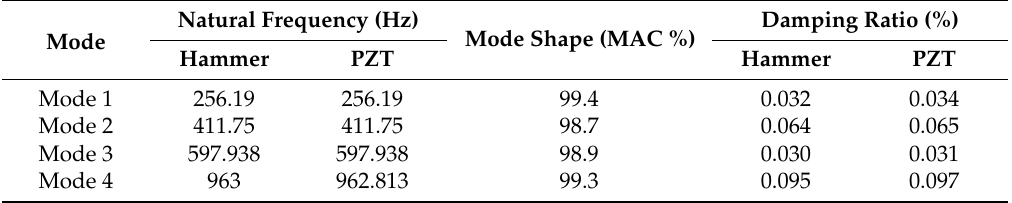
Table 1. Comparison of the modal parameters (natural frequencies, mode shapes and damping ratios) obtained with the Hammer and with the PZT (Chirp excitation).